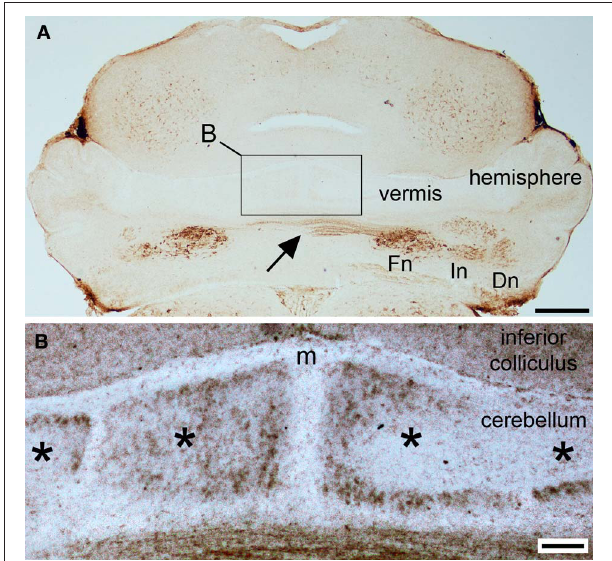
FIGURE 2 | NFH is expressed in parasagittal zones at postnatal day 2. (A) At P2, NFH is heavily expressed in all three sets of cerebellar nuclei [fastigial nucleus (Fn), interpositus nucleus (In), dentate nucleus (Dn)], in the commissural axons from the Fn (arrow), and weakly in broad zones of Purkinje cells in the vermis and hemispheres. (B) High power image of the midline (m) showing Purkinje cell zones (asterisks). Scale bar in (A) = 500 μ m and (B) = 100 μ